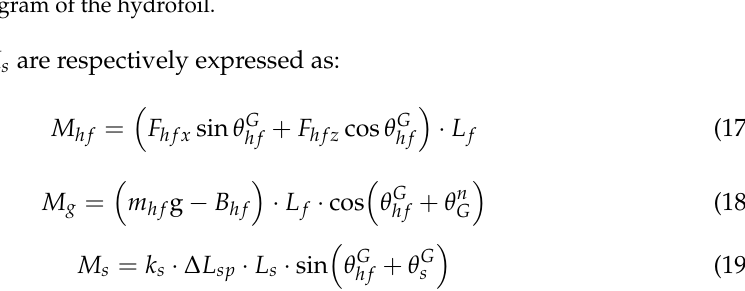
Figure 4. The force diagram of the hydrofoil.